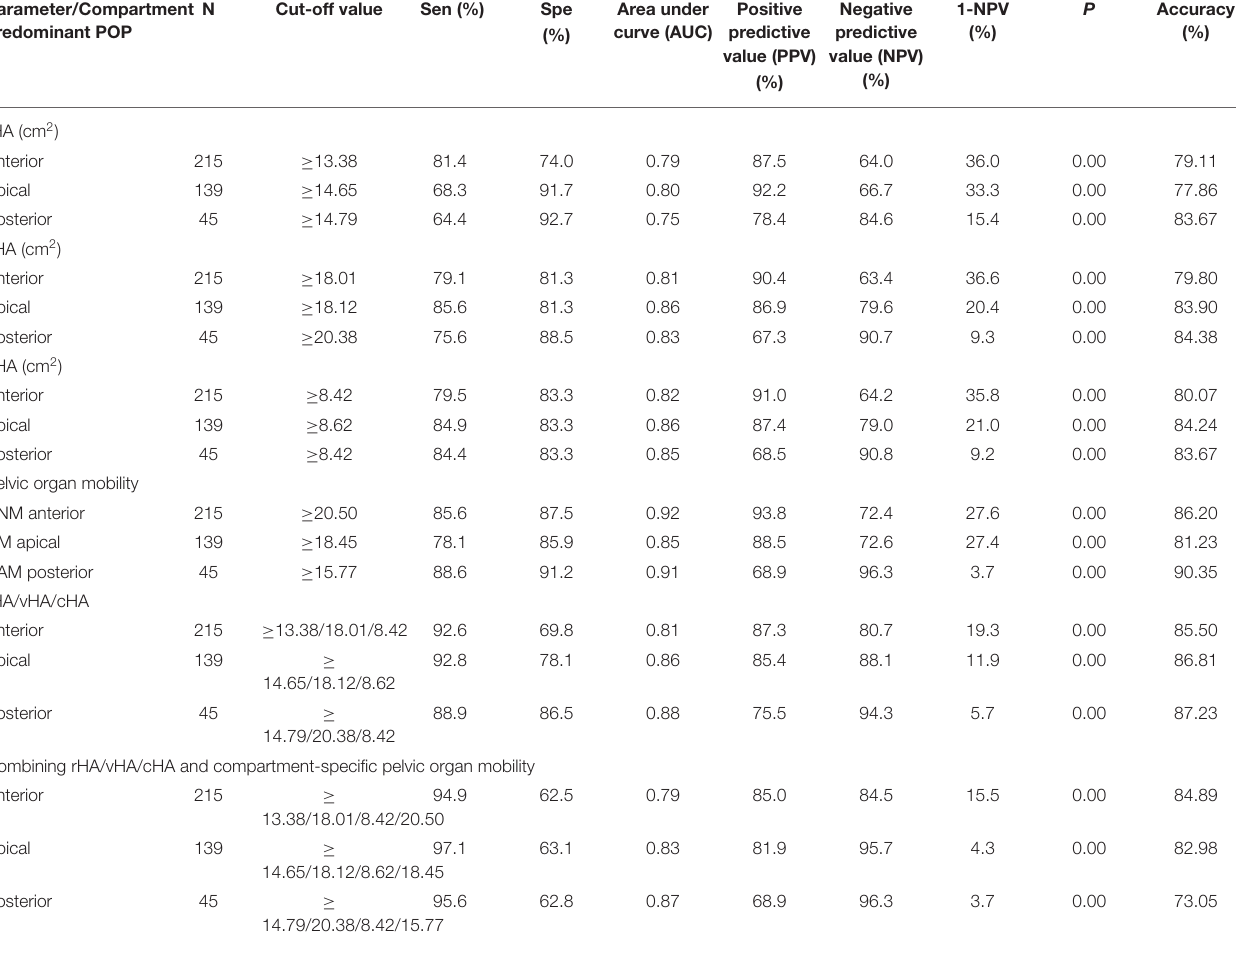
TABLE 5 | Receiver operating characteristic (ROC) analyses for the validity of using hiatal area at rest (rHA)/on Valsalva (vHA)/at contraction (cHA), and bladder neck mobility (BNM), cervix mobility (CM), and rectum ampulla mobility (RAM), either separately or in joint tests with transperineal ultrasound diagnosis of compartment predominant prolapse (International Continence Society POP quantification, grade II/